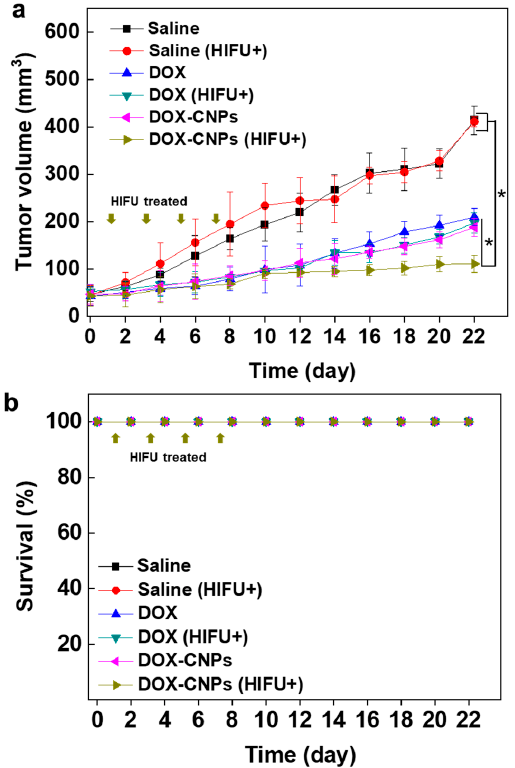
Figure 5. In vivo therapeutic efficacy of HIFU-triggered DOX-CNPs in ECM-rich A549 tumor-bearing mice. ( a ) Antitumor efficacy of DOX-CNPs with HIFU treatment ( n = 5 per group). The arrows indicate DOX-CNP injection and HIFU treatment (intensity: 5 W/cm 2 , frequency: 1.5 MHz, duty cycle: 10%, pulse repetition frequency: 1 Hz, time per spot: 30 s, interval: 2 mm, expose time: 5 min). (*) indicates di ff erence at the p < 0.05 significance level. ( b ) Survival rate of A549 tumor-bearing mice treated with saline, saline (HIFU + ), DOX, DOX (HIFU + ), DOX-CNPs, and DOX-CNPs (HIFU + ). The arrows indicate HIFU